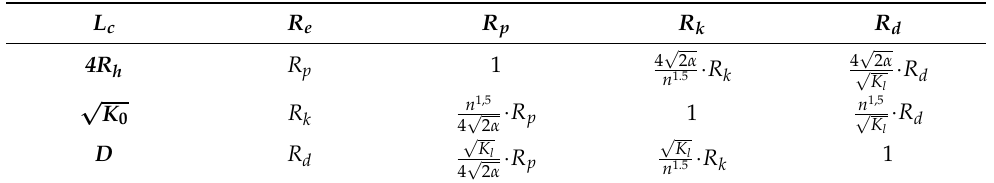
Table 2. Relationships among the Reynolds numbers R e